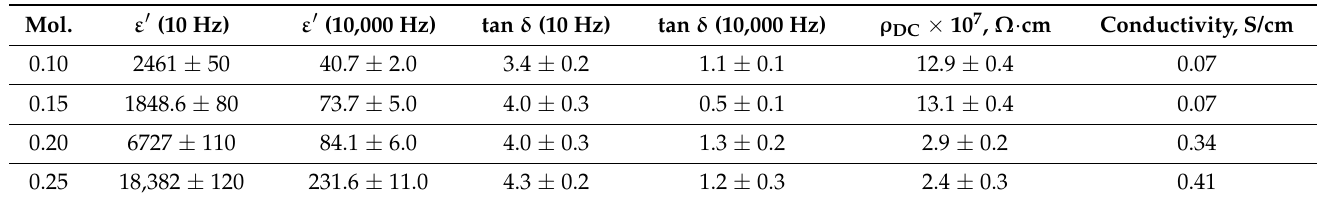
Table 3. Comparison of permittivity ε (cid:48) , dielectric loss tangent tan δ = ε ”/ ε (cid:48) at 10 Hz, 10,000 Hz and DC resistance ρ DC